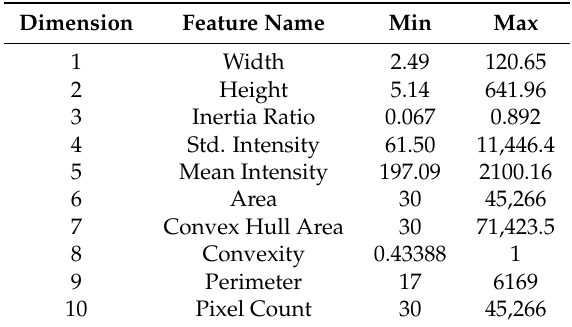
Table 3. 10D Feature and min, max values on Dataset ARACATI.